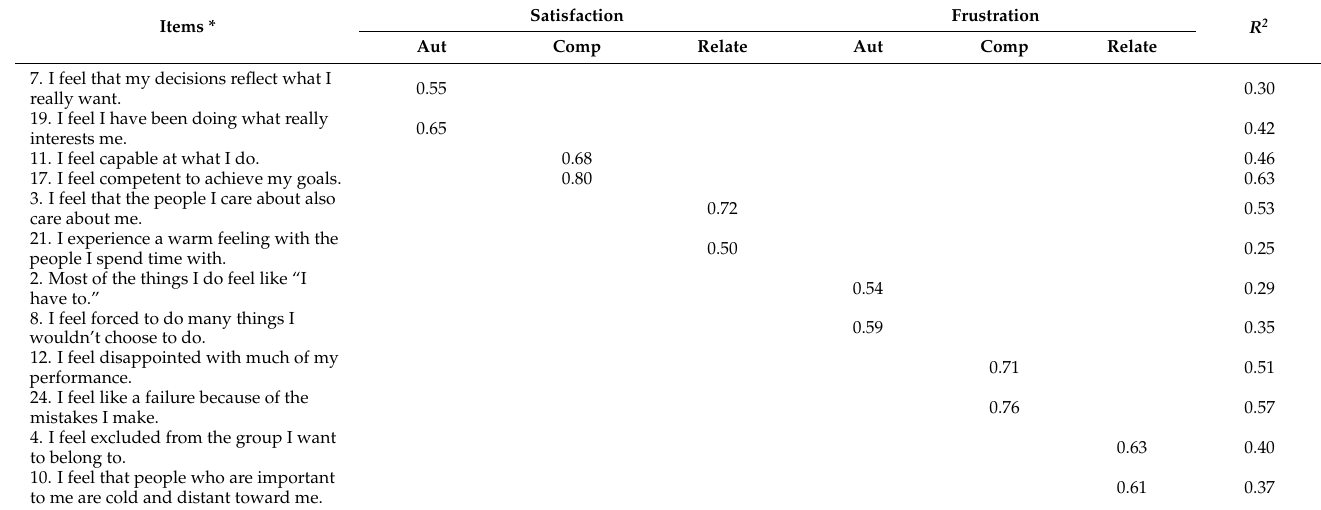
Table A2. Parameter estimates of confirmatory factor analysis (CFA) for the 6-factor model ( N = 344). Items *